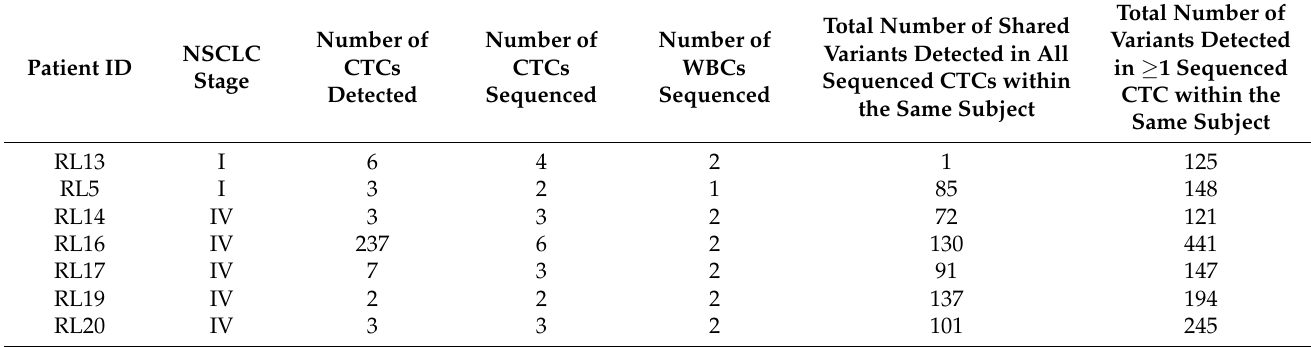
Table 3. NSCLC patients (N = 7) selected for single CTC